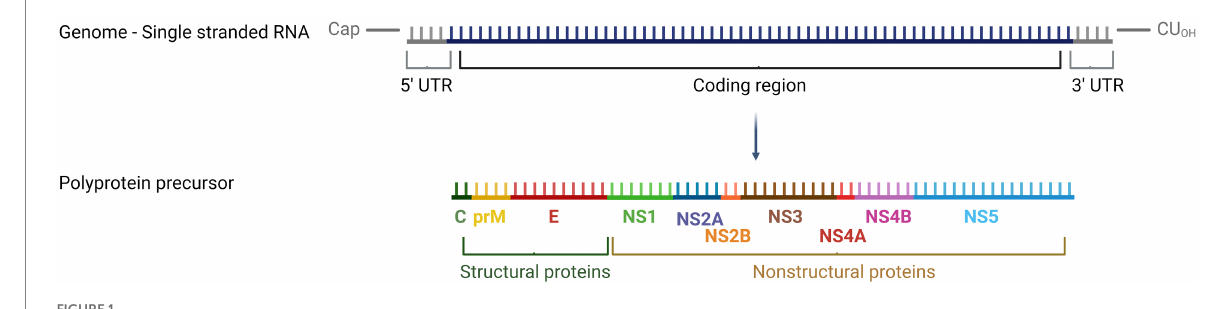
FIGURE 1 Schematic view of the USUV genome structure. Created with